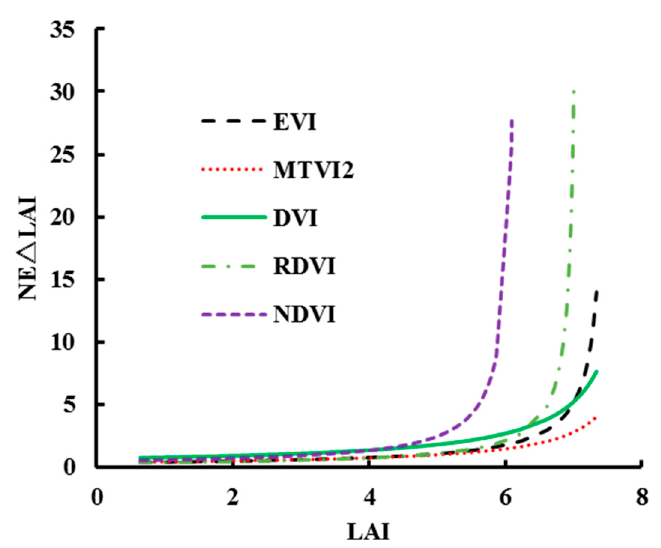
Figure 4. Saturation sensitivity of selected VI S to LAI.